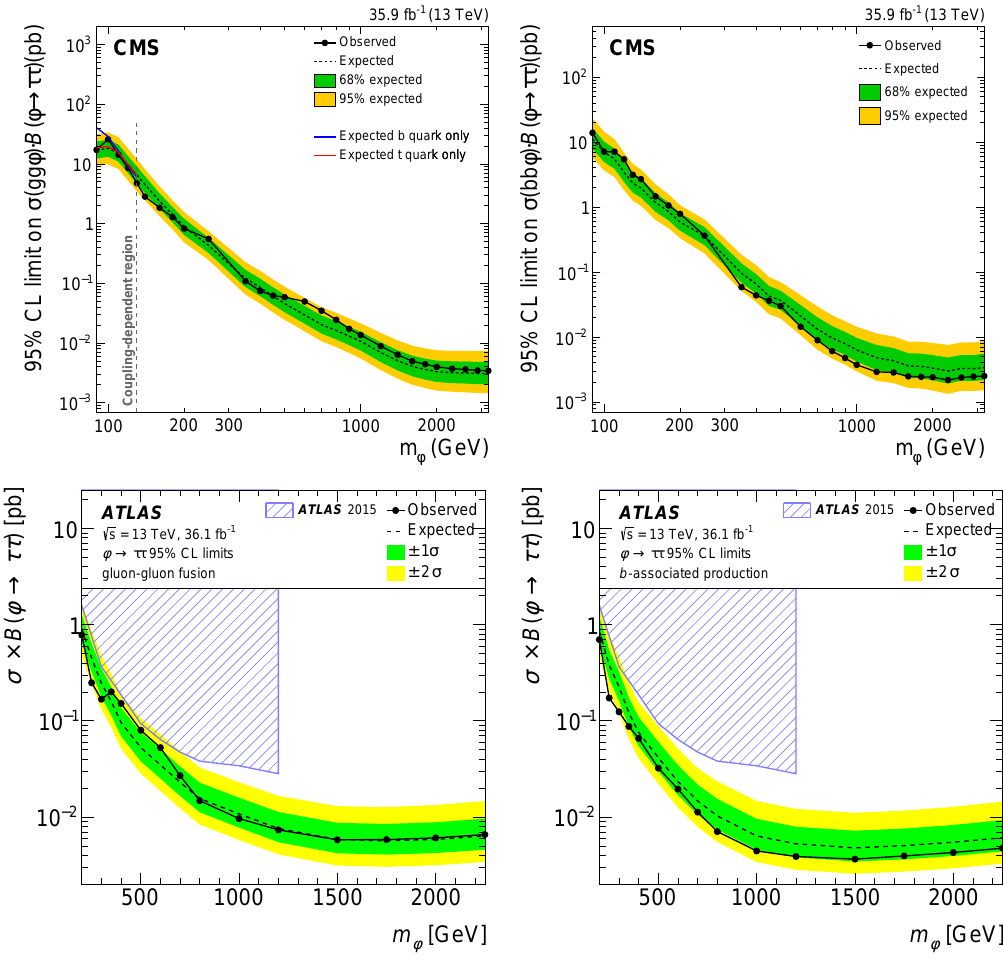
Figure 2: (top) CMS expected and observed limits on σ ( φ ) × BR ( φ → ττ ) for (left) the gluon fusion and (right) the b ¯ b -associated production, resulting from the combination of all the four channels considered. (bottom) ATLAS expected and ob- served limits on σ ( φ ) × BR ( φ → ττ ) for (left) the gluon fusion and (right) the b ¯ b -associated production, resulting from the combination of all the three channels considered. [ 11 ] [ 12